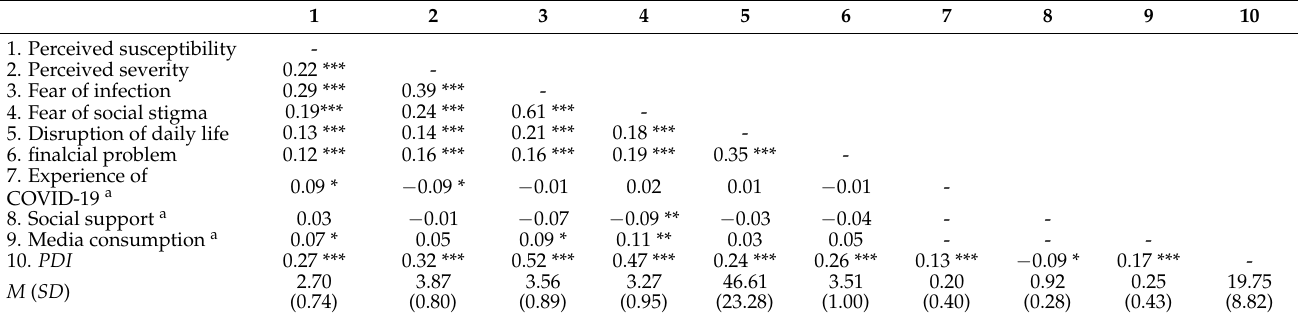
Table 3. Correlations between risk perception, fear, COVID-19-related experience, and